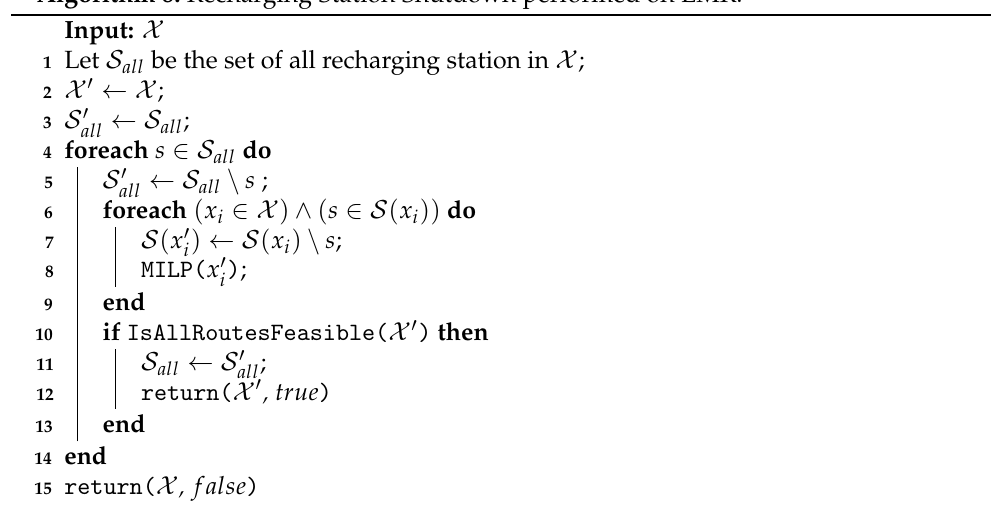
Algorithm 8: Recharging Station Shutdown performed on